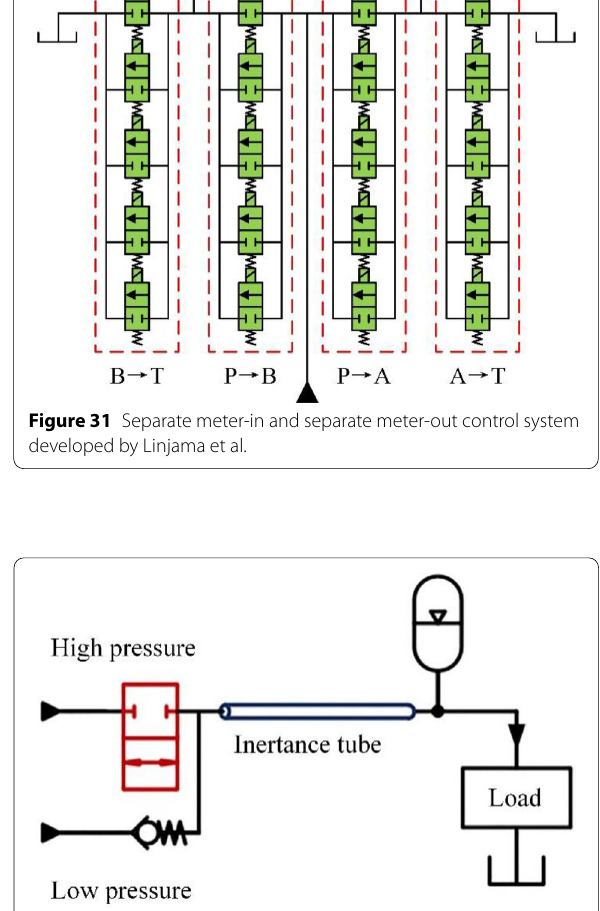
Figure 32 Switched inertance hydraulic system provided by Manhartsgruber et al.